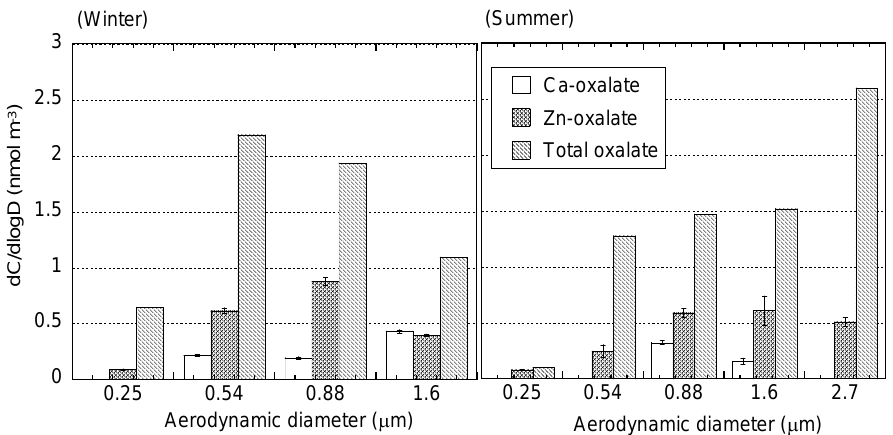
Fig. 7. Atmospheric concentrations of Ca oxalate, Zn oxalate, and total oxalate during winter and